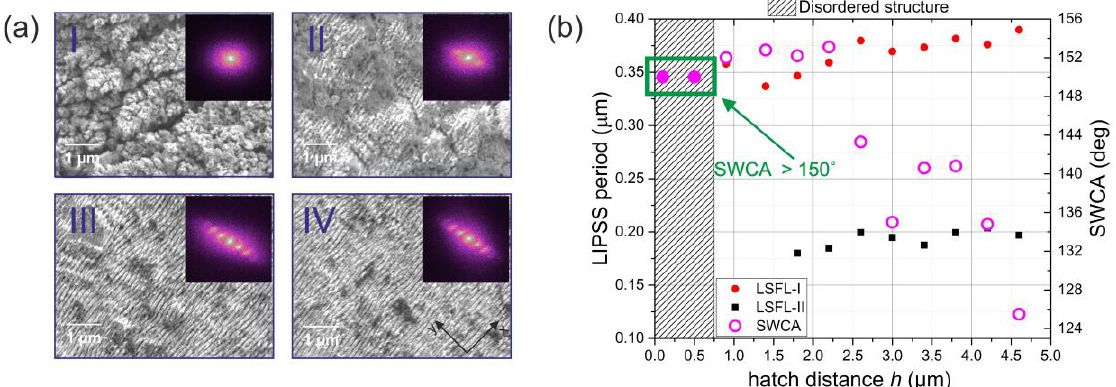
Figure 4. ( a ) SEM micrographs of the steel surfaces, laser patterned using various h values: ( I ) — 0.1 µm, ( II ) — 0.9 µm, ( III ) — 3.4 µm, and ( IV ) — 4.6 µm (each SEM micrograph inset shows its 2D-FFT image). All samples were prepared using constant fluence (0.25 J/cm 2 ). ( b ) Dependence of the LIPSS period and SWCA value on the hatch distance h.